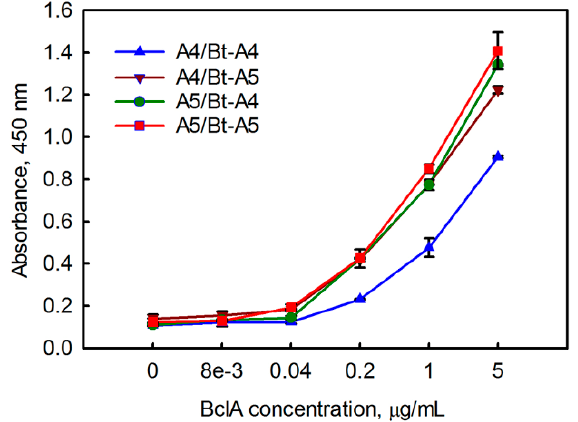
Figure 3. Dose response curves using combinations of A4 and A5 capture/tracer pairs. In each case the tracer is biotinylated (Bt). Measurements were performed in duplicate; the error bars represent the average deviation.